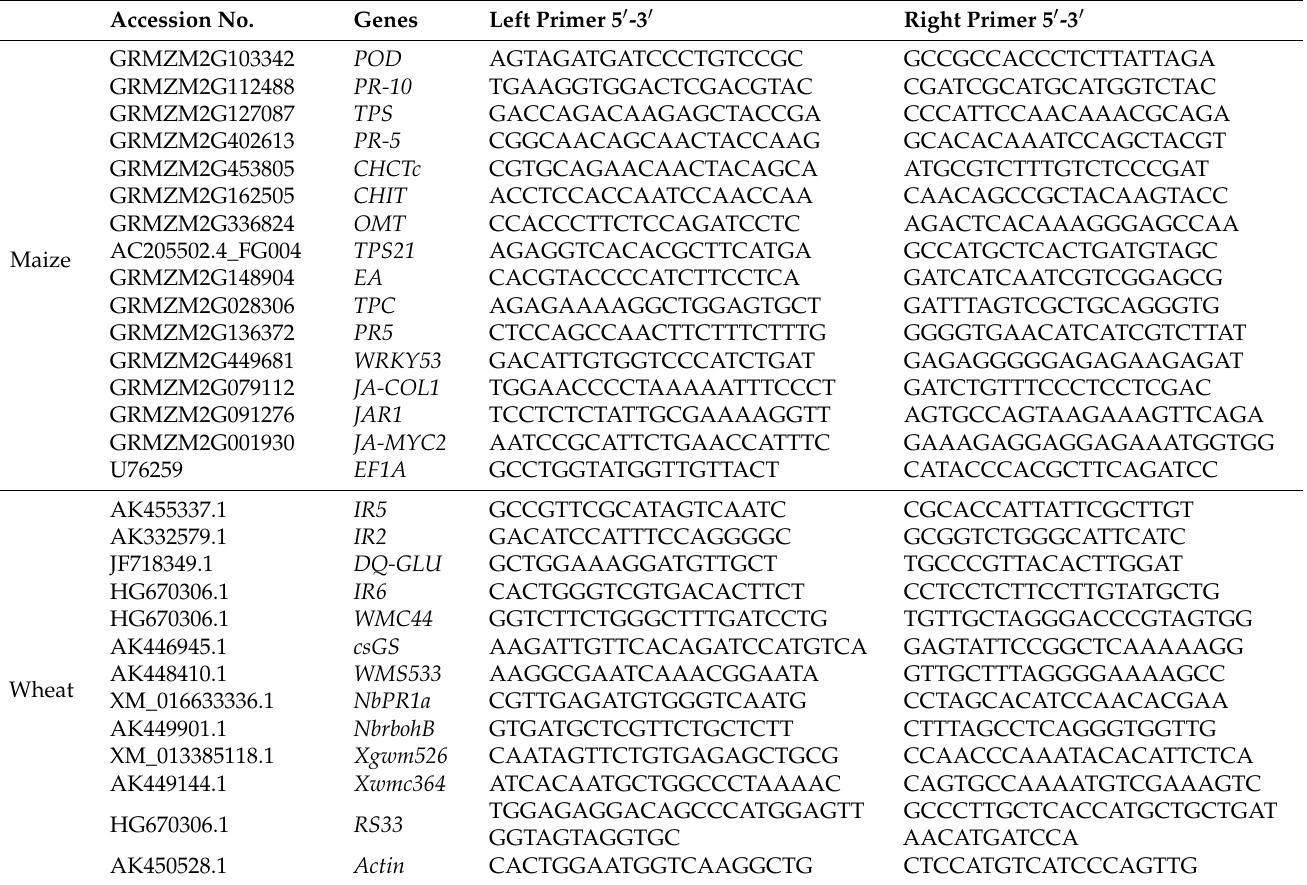
Table 1. Groups of real-time quantitative PCR (RT-qPCR) primers used to amplify genes pecific regions. Accession No. Genes Left Primer 5 (cid:48) -3 (cid:48) Right Primer 5 (cid:48) -3 (cid:48)